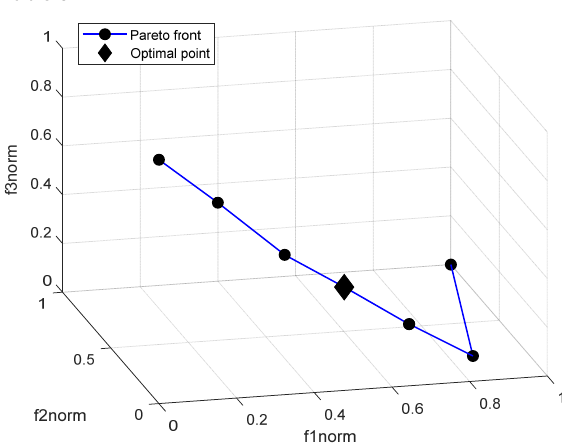
Figure 5. The normalized Pareto front and the optimal point for solution № 5 from Table 8